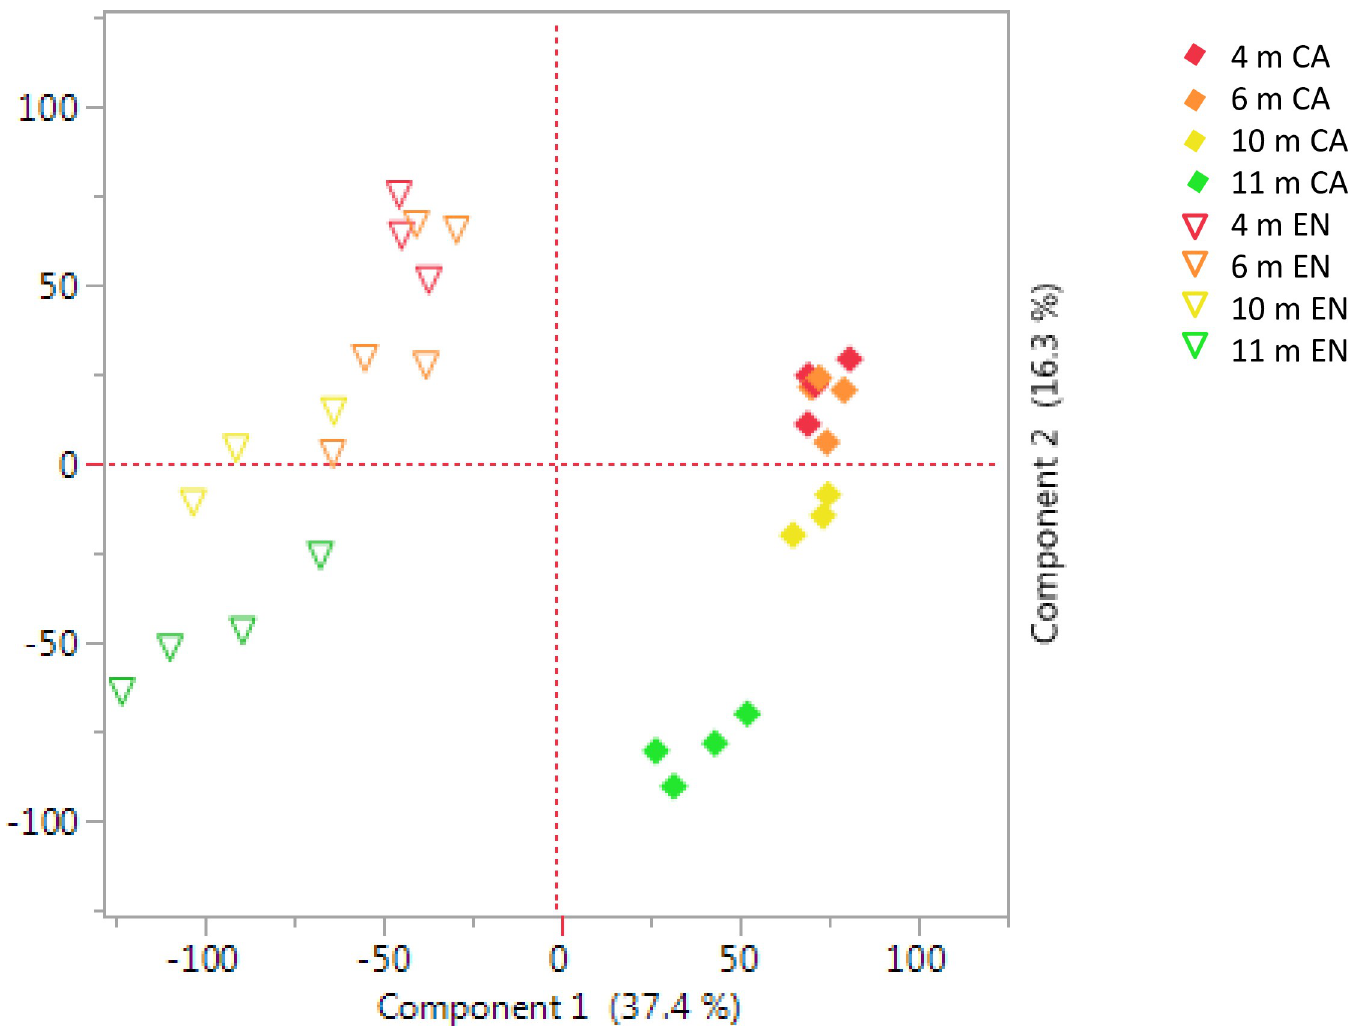
Fig 6. Principal components analysis. Evaluation of clustering of samples by principal components analysis to identify outliers. Diamonds–chorioallantois (CA); Triangles–endometrium (EN). Red– 4 m gestation; orange– 6 m gestation; yellow– 10 m gestation; green– 11 m gestation.